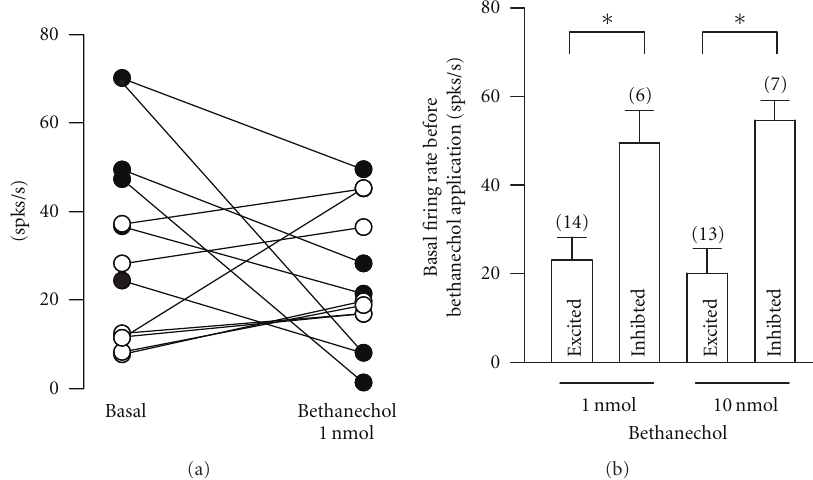
Figure 2: The e ff ect of local activation of MRs depends on the firing rate before the application of di ff erent doses of bethanechol. (a) Shows that bethanechol 1nmol produces heterogeneous e ff ects on the spiking rate of globus pallidus neurons depending on the baseline firing rate before drug application. Only data from six neurons that su ff ered excitation are plotted. (b) Statistics showing that the excitation or inhibition evoked by 1 and 10nmol bethanechol depends on the predrug baseline firing rate. ∗ P < 0 . 01; t -test. spks/s, spikes per second.